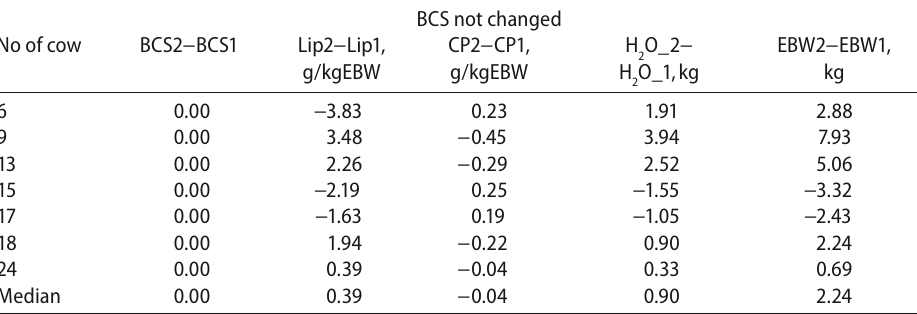
Values of differences of parameters and their medians for cows at II phase of lactation whose BCS did not